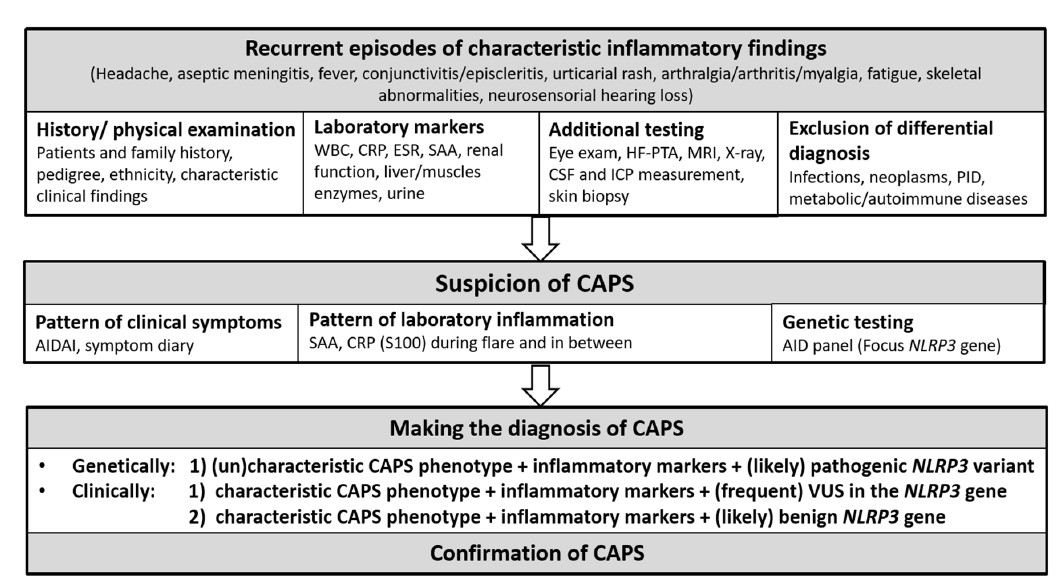
Figure 1. Diagnostic approach to CAPS. WBC, whole blood count; CRP, c reactive protein; ESR, erythrocyte sedimentation rate; SAA, serum amyloid A; HF-PTA, high frequency pure tone audiogram; MRI, magnet resonance imaging; CSF, cerebrospinal fluid; ICP, intracranial pressure; PID, primary immune deficiency; AIDAI, autoinflammatory disease activity index; S100, S 100 proteins (S100A12, S100A8/A9); VUS, variant of uncertain significance. Bold format and grey background indicate headings.